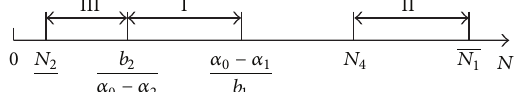
Figure 7: The optimal compensation mechanism in different